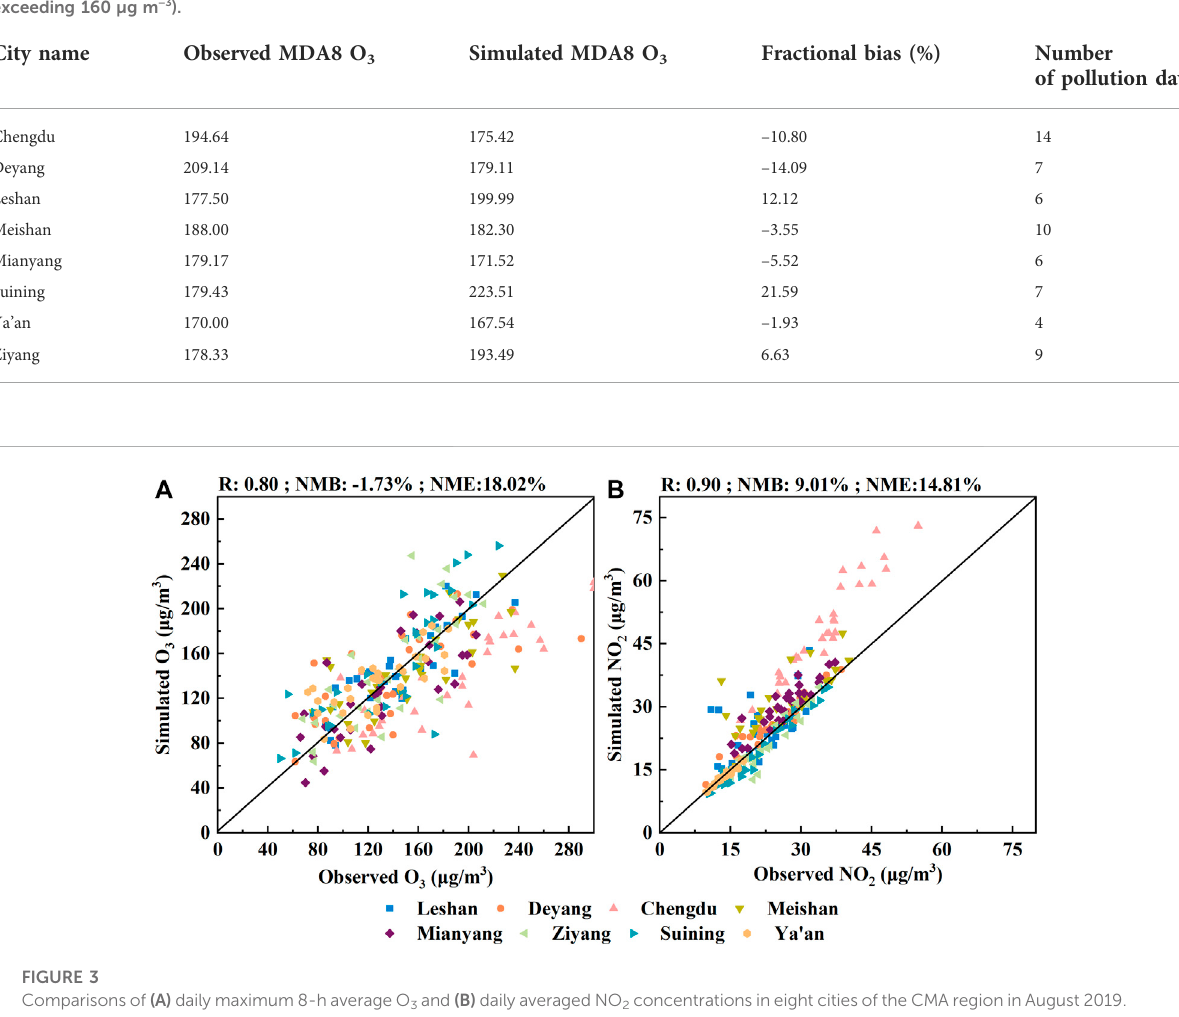
Figure 3 . The observed MDA8 O 3 concentrations and the daily NO 2 concentrations averaged over the monitoring sites in each city are used against the simulated data. The simulated MDA8 O 3 concentrations in August 2019 are extracted from the modeling grids where the monitoring stations are located. A total of 37 national monitoring stations in the eight cities in CMA are chosen for model validations (Figure 1C). The statistical metrics, correlation coef fi cient (R), normalised mean bias (NMB) and normalised mean error (NME) show that the correlations between simulated and observed O 3 and NO 2 concentrations